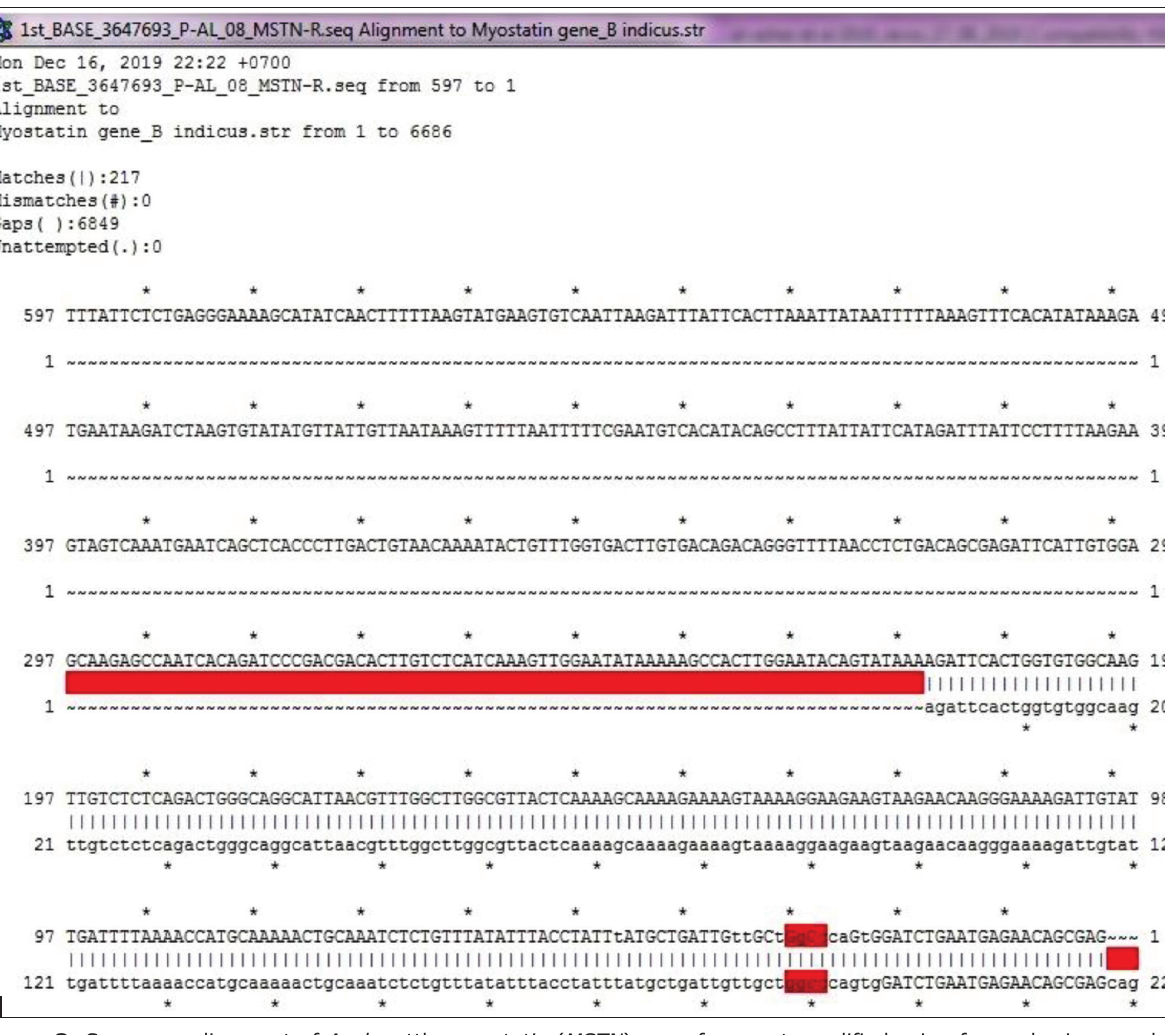
Fig ure-3: Sequence alignment of Aceh cattle myostatin ( MSTN ) gene fragment amplified using forward primer and Bos indicus MSTN gene (a) and Aceh cattle MSTN gene fragment amplified using reverse primer and B. indicus MSTN gene (b) (a) sequence alignment of MSTN gene B. indicus and Aceh cattle (b) Sequence alignment of MSTN gene Bos taurus and Aceh